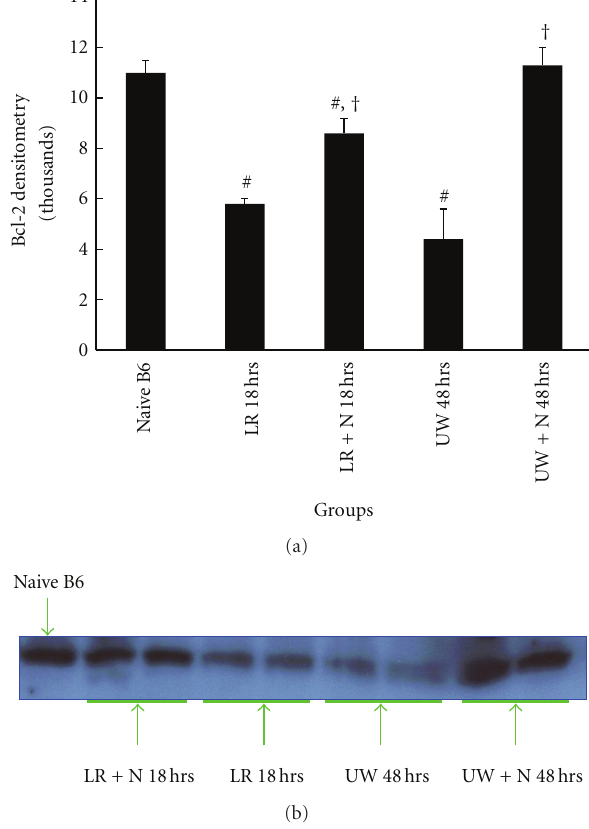
Figure 8: Nitrite-supplemented solutions mitigated reductions in Bcl-2 concentrations. Bcl-2 protein (pooled from 3 livers per condition) expression decreased during cold preservation with both LR (18 hours) and UW solutions (48 hours) alone but significantly increased when the respective solutions were supplemented with 250 µ M of anion nitrite (LR—5 . 9 ± 0 . 6 versus LR + nitrite—8 . 8 ± 1; UW—4 . 4 ± 1 . 3 versus UW + nitrite—10 . 8 ± 1 . 1). Supplemented UW solution demonstrated the greatest increase in protein expression. Data are expressed as mean ± SE. # P < 0 . 05 for corresponding